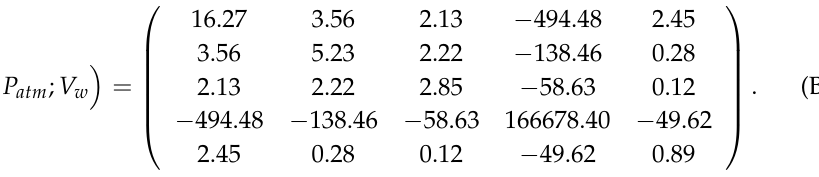
Table B8. Statistics of the wind speed distribution [m/s].